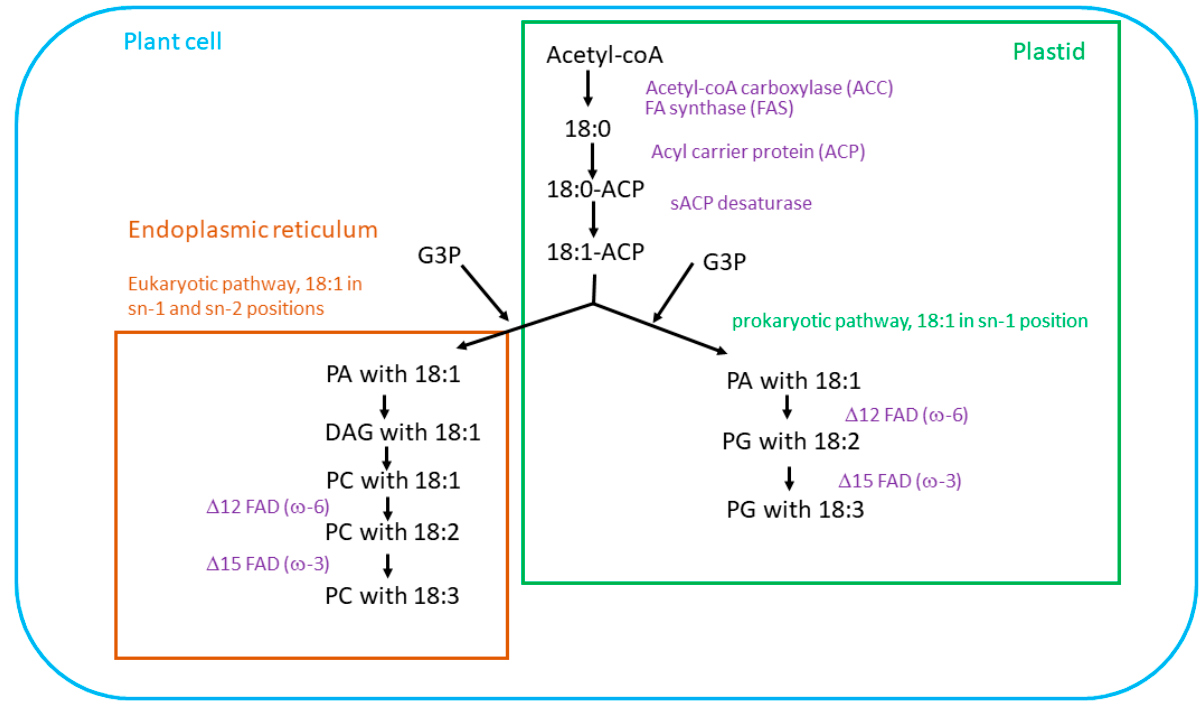
Figure 2. An oversimplified scheme of plant fatty acid biosynthesis. Phopspholipids PA and PC are shown as examples. G3P—glycerol-3-phosphate, PA—phosphatidic acid, PG—phosphatidyl glycerol, PC—phosphatidylcholine, DAG—diacylglycerol.